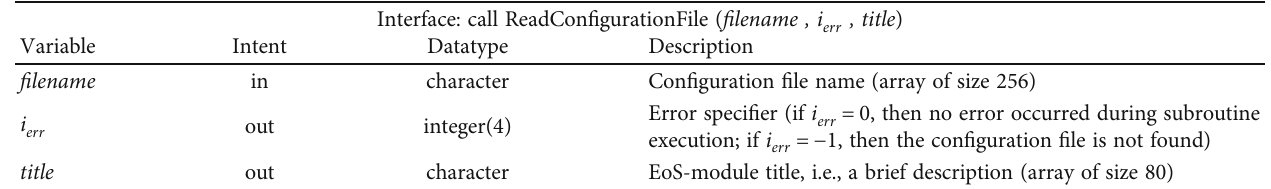
Table 1: API for ReadCon fi gurationFile .